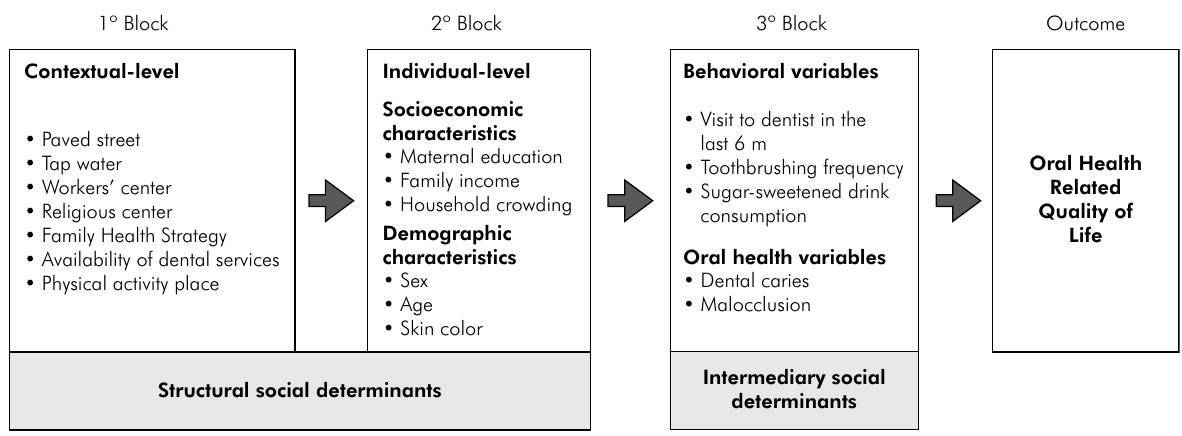
Figure 1. Theoretical model for the study of determinants of OHRQoL in adolescents, adapted from Word Health Organization. 23